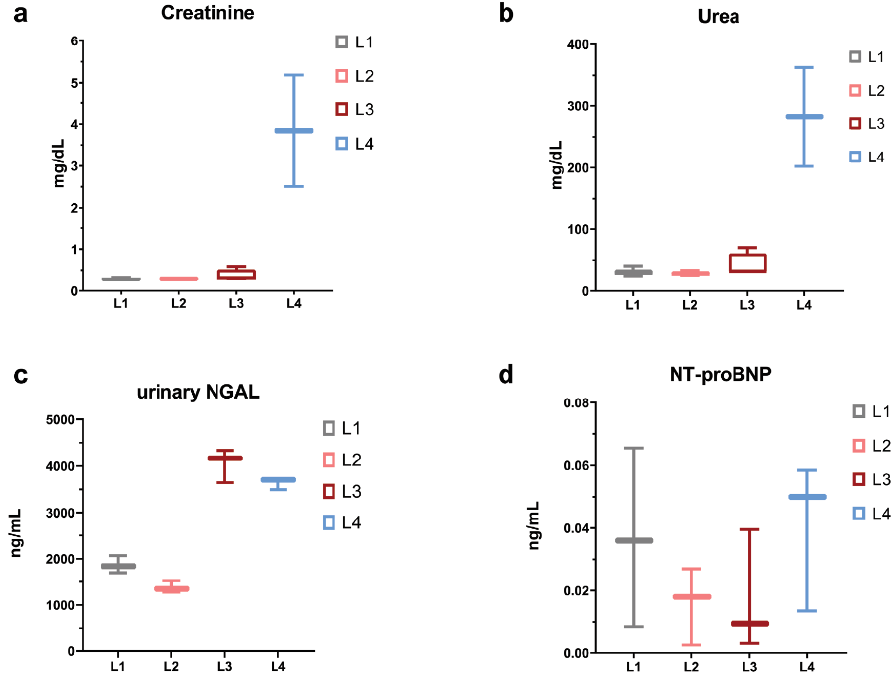
Figure 2. Serum biochemical parameters, as a snapshot taken at end of study, disclosing an apparent lack of doxorubicin renal ( a , b ) and cardiac toxicity ( d ), while the urinary tubular marker NGAL ( c ) differentiates between early and delayed doxorubicin-treated rats, as well as for renocardiac group.